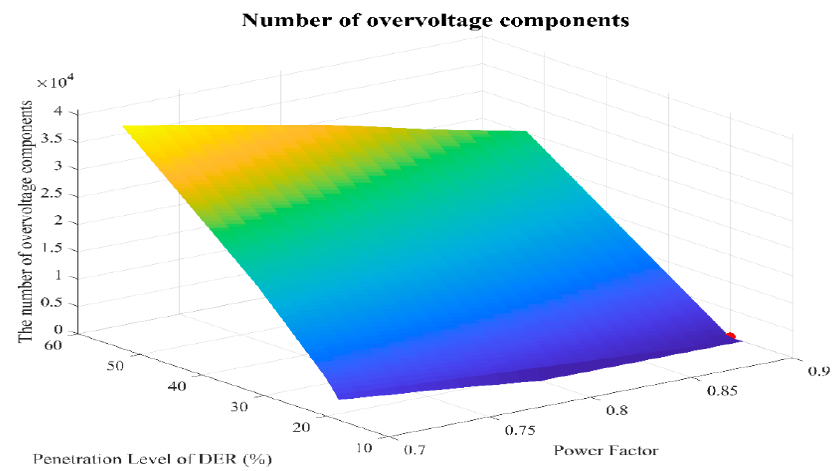
Figure 13. The number of overvoltage components at different power factors and penetration levels.